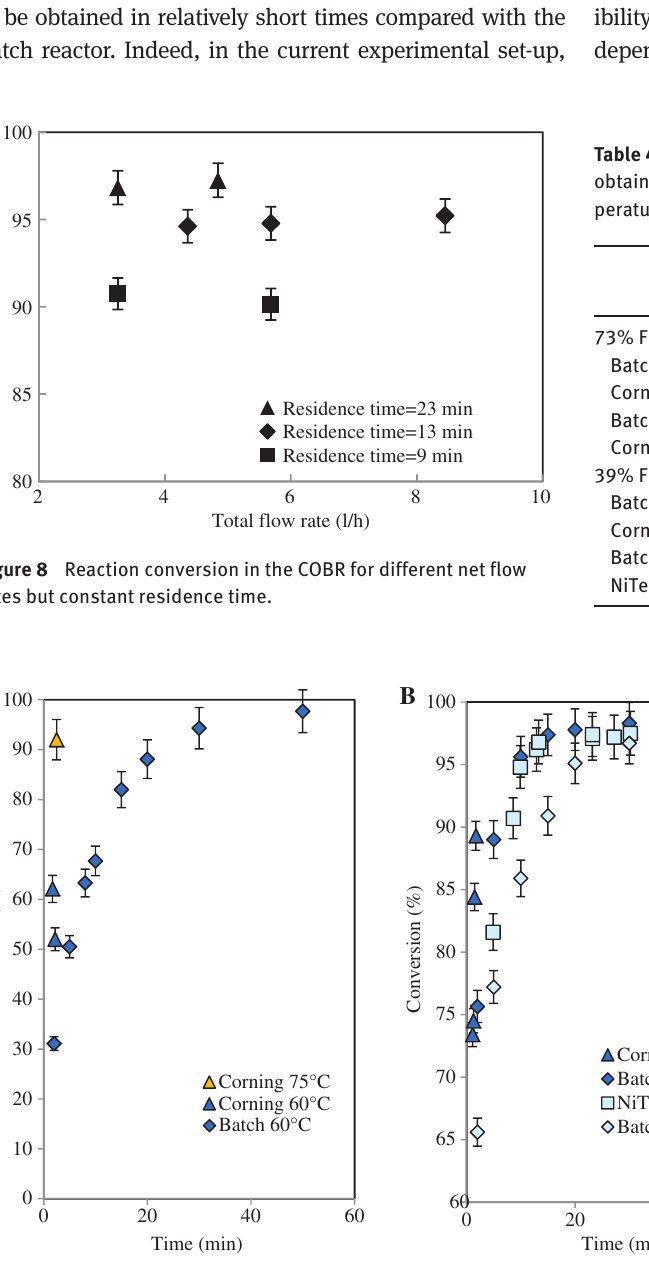
Figure 9 Comparison of esterification performance for the conversion of fatty acids using an oil with initial level of fatty acid of (A) 73% and (B) 39%.